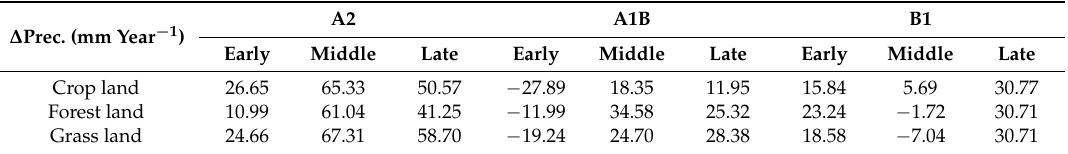
Figure 5. Seasonal changes of precipitation and air temperature over four seasons throughout three future periods under three SRES scenarios. Table 3. Annual changes of precipitation of three major land covers in three future periods under three SRES scenarios.